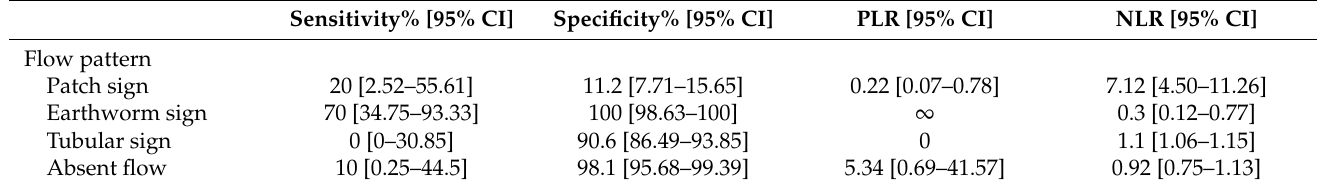
Table 4. Diagnostic performance of each flow pattern under Power Doppler ultrasound in predicting intravascular injection during caudal epidural